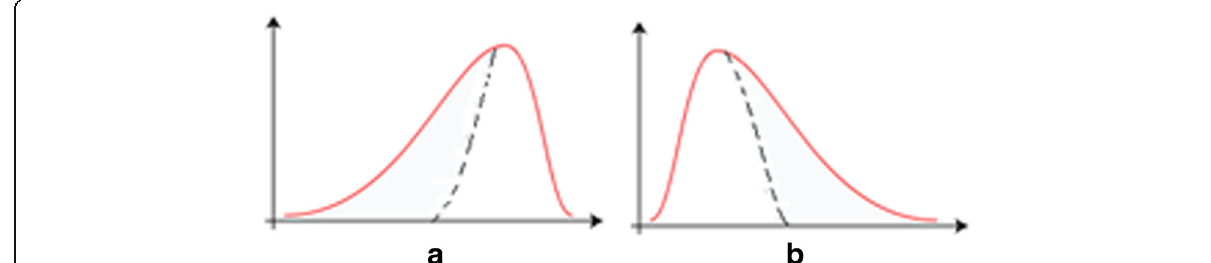
Fig. 1 a Negative skewness — the left tail is longer and the mass of the distribution is concentrated on the right of the figure. b Positive skewness — the right tail is longer and the mass of the distribution is concentrated on the left of the figure